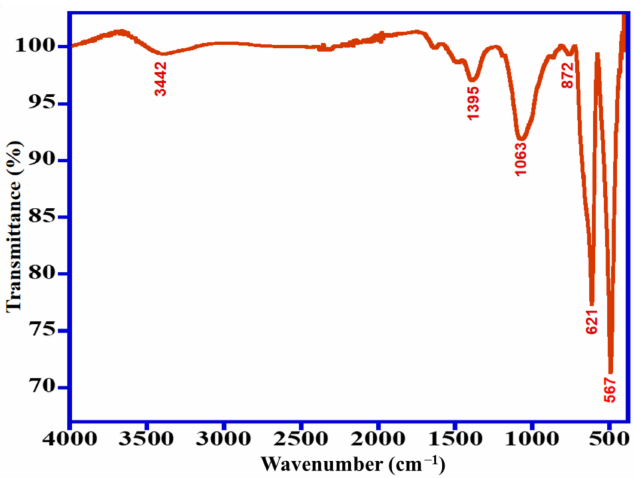
Figure 2. FT-IR spectra of the synthesized Mn 3 O 4 /ZnO/Eu 2 O 3 photocatalyst. Figure 3 demonstrates the XRD patterns of Mn 3 O 4 , ZnO, Eu 2 O 3 and Mn 3 O 4 /ZnO/ Eu 2 O 3 NPs. All diffraction reflections of Figure 3a are crystalline in nature and a mixture from hexagonal and tetragonal structures of ZnO, Mn 3 O 4 and Eu 2 O 3 . Figure 3b displayed